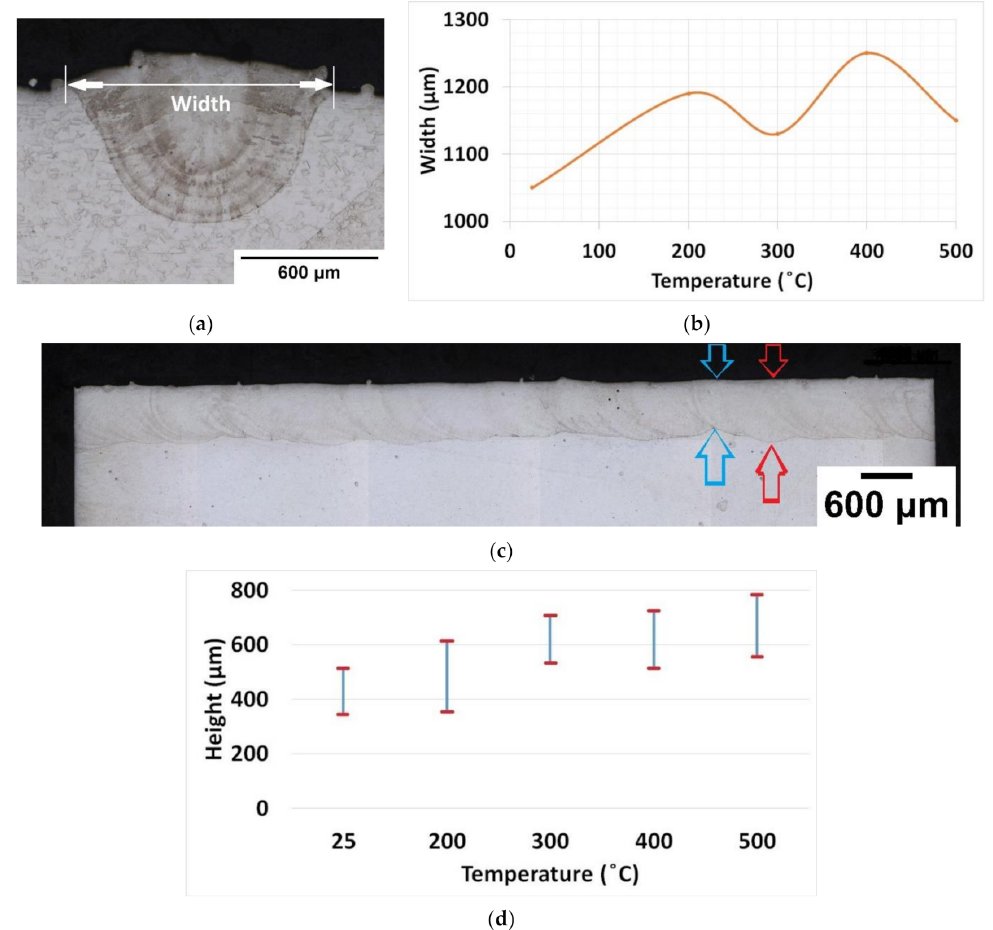
Figure 10. ( a ) Width measurement in the preheating 500 ◦ C optical microscope image ( b ) Width plot for different base plate preheating temperature ( c ) Height measurement in the preheating 500 ◦ C ( d ) Height measurement